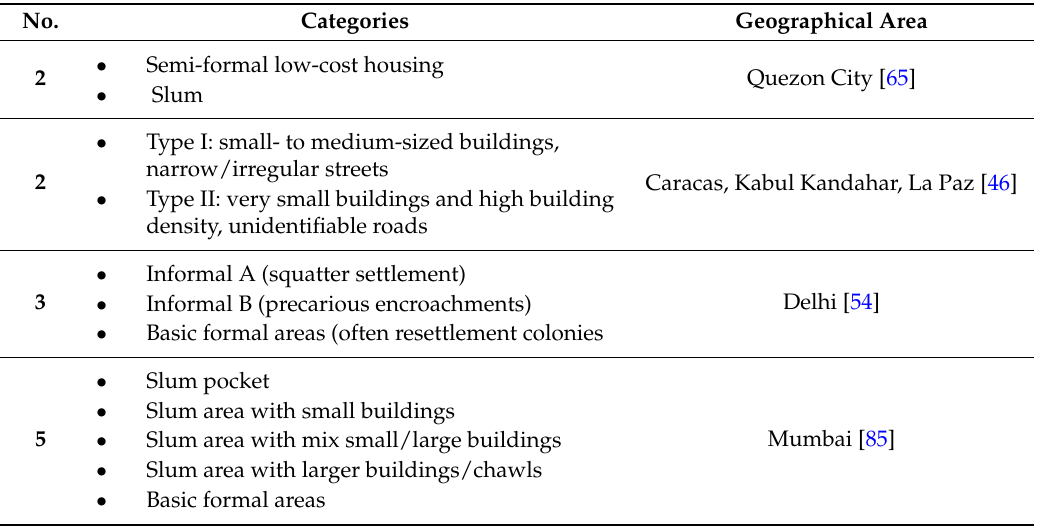
Table 5. Slum typologies and their categories.